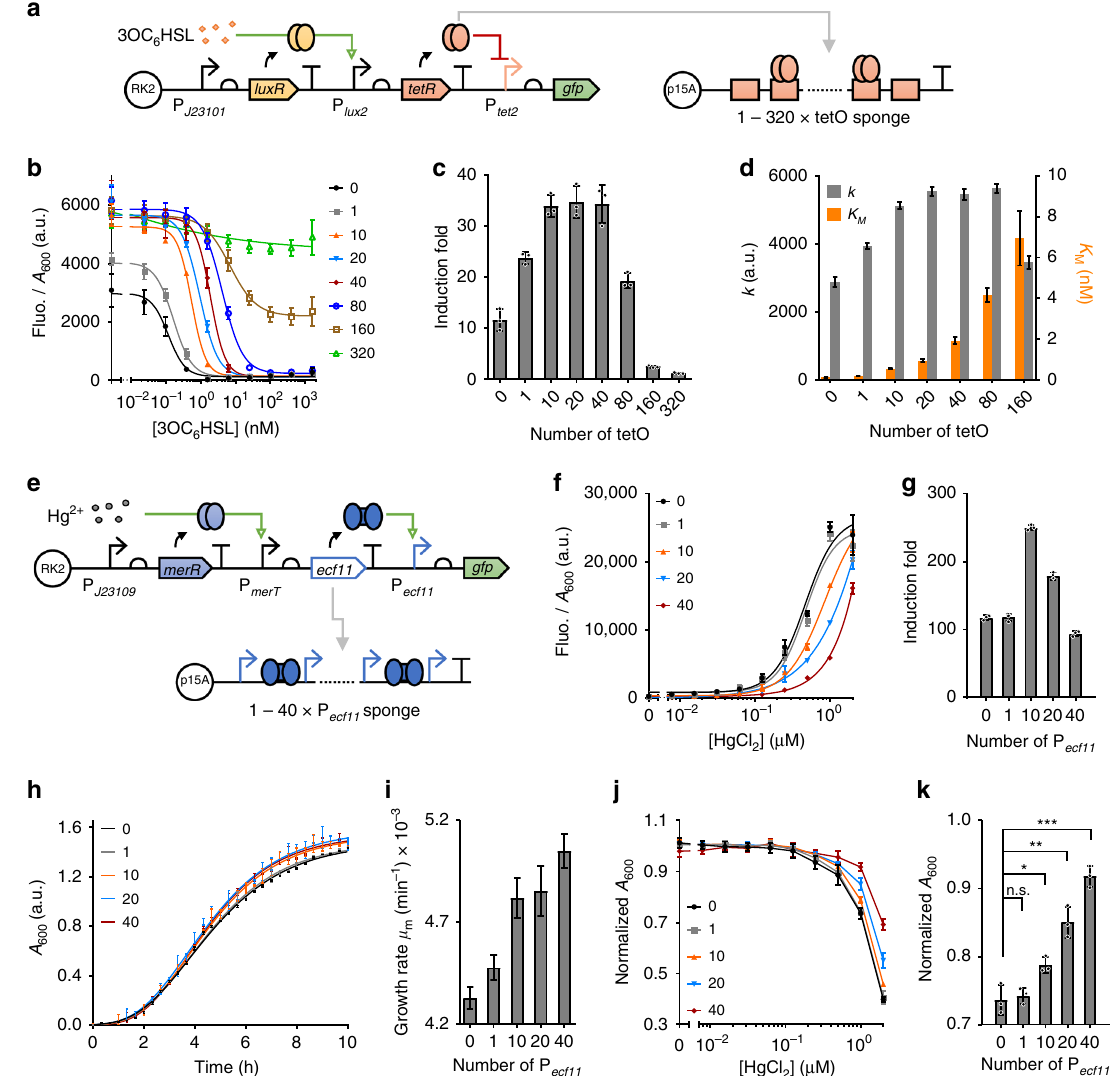
Fig. 3 Synthetic DNA sponge enables tuning output gene expression and mitigating cellular burden by decoying transcription factors within circuits ’ signal processing modules. a Schematic of a two-layered AHL-responsive circuit regulated by sponges containing 1 – 320 tetO repeats. b Characterization of the two-layered sensing circuit in response to various concentrations of 3OC 6 HSL and with sponges containing 1 – 320 tetO repeats. c Induction fold between uninduced and 1.6 μ M 3OC 6 HSL induced samples of the circuit characterized in ( b ). d Hill constant ( K M ) and the maximum output ( k ) of the circuit ’ s dose-responses characterized in ( b ). Values of sample with sponge containing 320 tetO repeats is not shown due to insuf fi cient dose-response of the circuit. e Illustration of a two-layered mercury-responsive circuit regulated by sponge containing 1 – 40 P ecf11 repeats. f Dose-responses of the mercury- responsive circuit with sponges containing different numbers of P ecf11 repeats. g Induction fold between uninduced and 1 μ M HgCl 2 induced samples of the circuits characterized in ( f ). h Gompertz model fi tted cell growth curves of the mercury-responsive circuit with sponge containing 1 – 40 P ecf11 repeats in response to 1 μ M mercury. i Growth rate ( μ m ) of the cells at exponential growth phase as characterized in ( h ). j Normalized cell densities of the circuits tested in ( f ). Cell densities are normalized to the ones of negative control (with empty sensor and empty sponge plasmids). k Normalized cell densities of the circuit induced with 1 μ M mercury as characterized in ( j ). Statistical difference is determined by a two-tailed Welch ’ s t test: 1, p = 0.6987, t = 0.4257; 10, p = 0.0381, t = 3.518; 20, p = 0.0035, t = 6.158; 40, p = 0.0006, t = 11.44. For ( b , c , f – h , j , k ), values are mean ± s.d. ( n = 3 biologically independent samples). For ( d , i ), values are mean ± s.e.m. ( n = 3 biologically independent samples). Fluo., fl uorescence. a.u., arbitrary units. p value